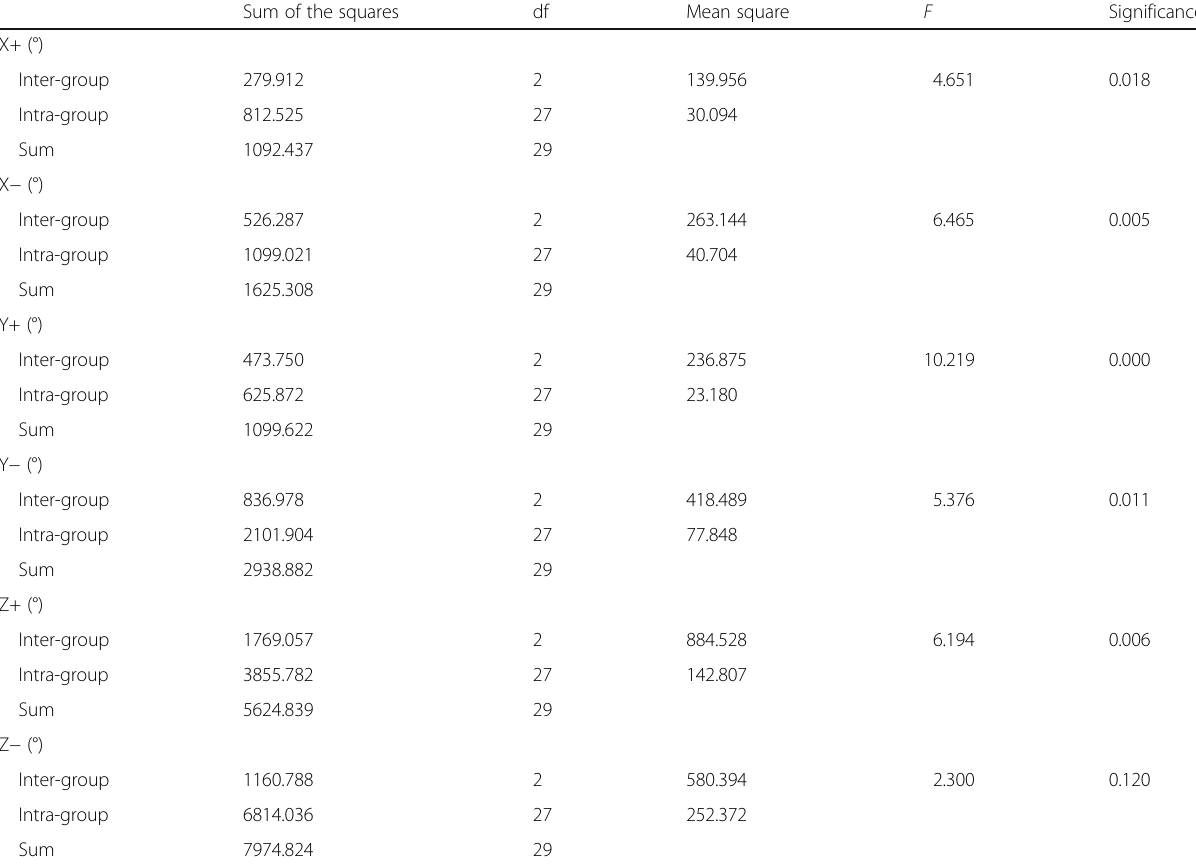
Table 2 Analysis of variance the maximum operating angle in six movement directions Sum of the squares df Mean square F